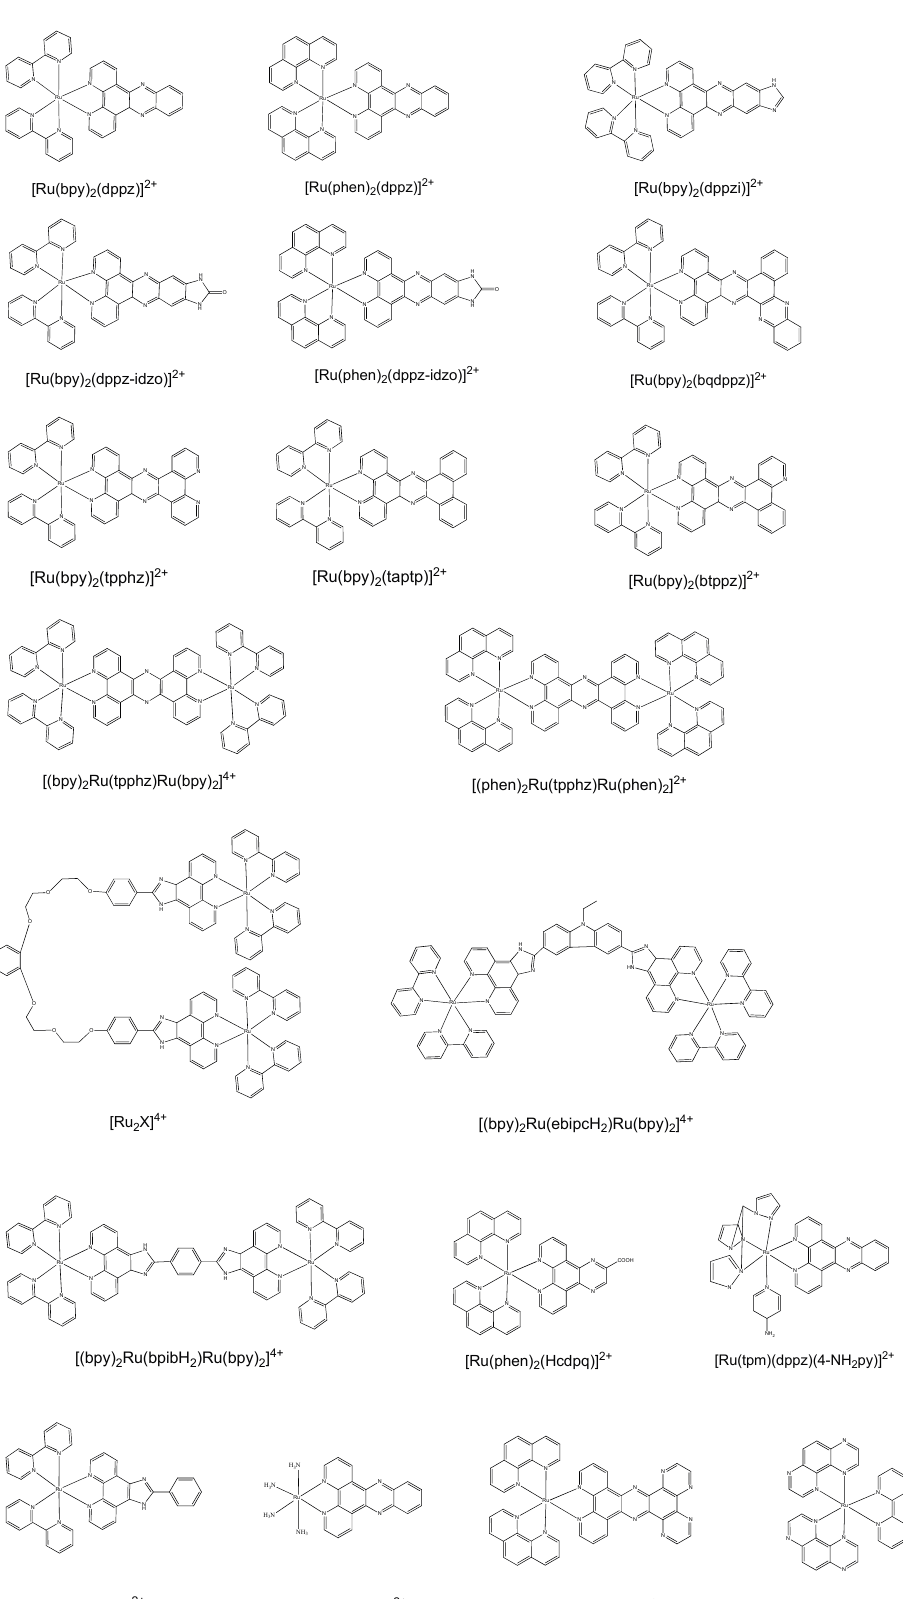
Figure 24. Structures of selected ruthenium complexes as “light switch”